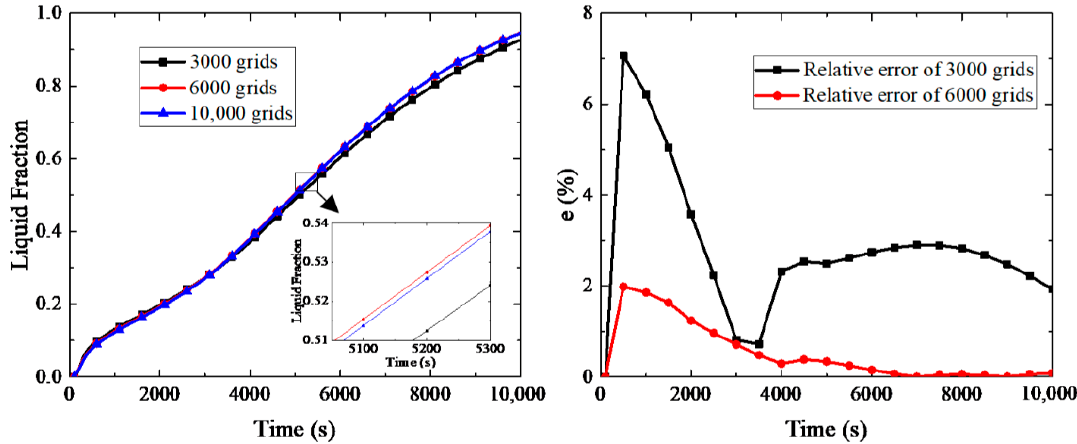
Figure 7. Results of time step independent analysis.